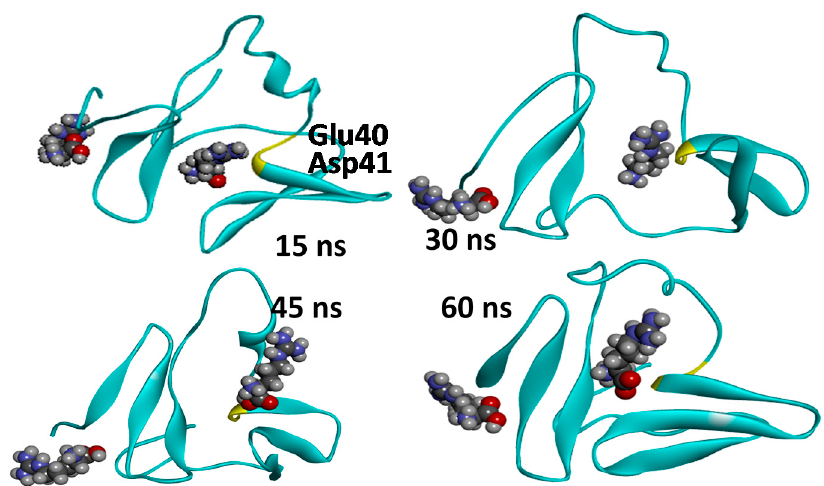
Figure 4. Snapshots of the 60-ns MD simulation performed with the solutions obtained from GLUE. Two Arg molecules were considered so that both hotspots identified by GLUE were represented. WW34 protein is displayed as ribbons in green and the two arginine molecules are displayed as CPK and coloured by element. The reference residues Glu40 and Asp41 are highlighted in yellow in each snapshot.